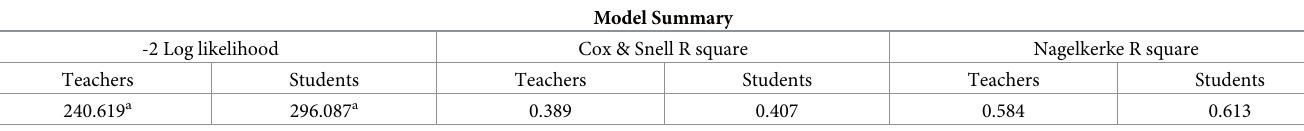
Table 3. Comparative model